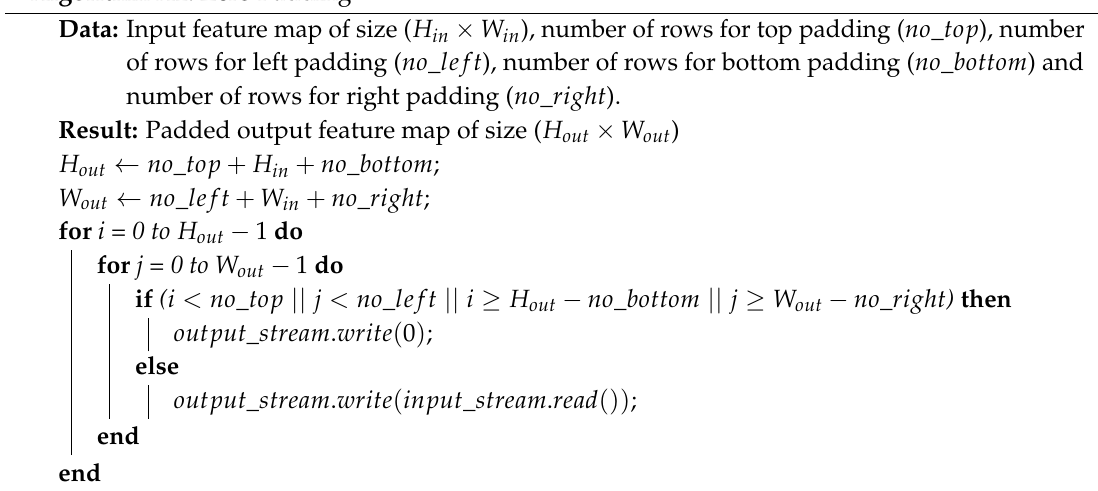
Algorithm A2: Zero